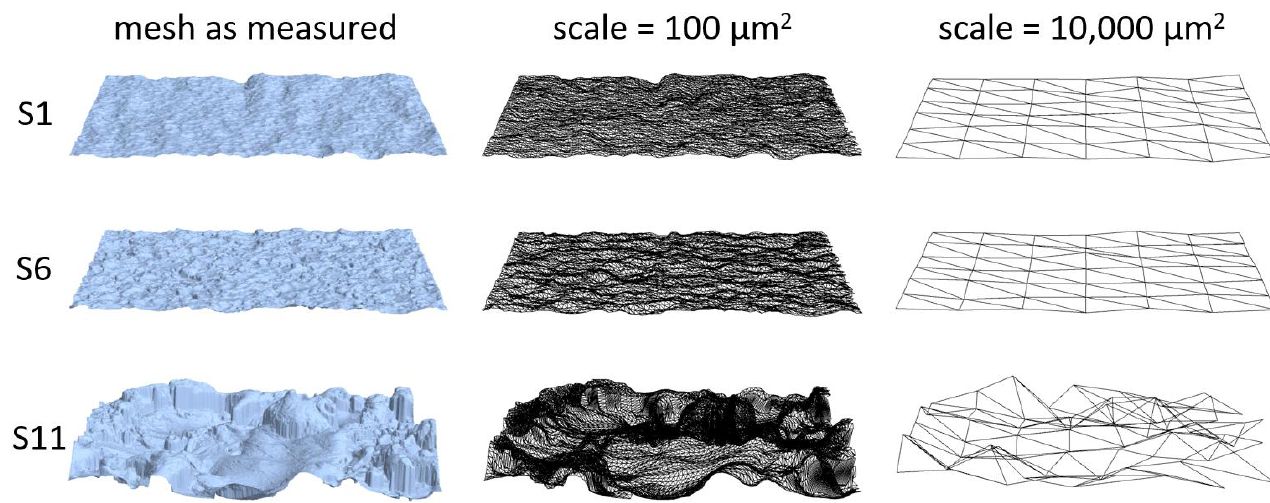
Figure 4. Effect of scale manipulation in the area-scale method for three different surfaces S1, S6, and S11: mesh as measured (left column), renderings of triangulated surfaces for scale equal to 100 µ m 2 (middle column) and 10,000 µ m 2 (right column) visualized in wireframe style. Please note that each row represents different surfaces.